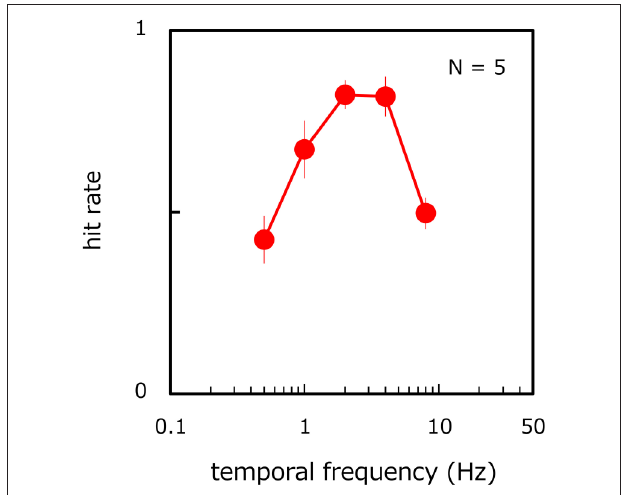
FIGURE 6 | Hit rate of target presence/absence as a function of the temporal frequency of target velocity modulation. Error bars represent ± 1 SE across